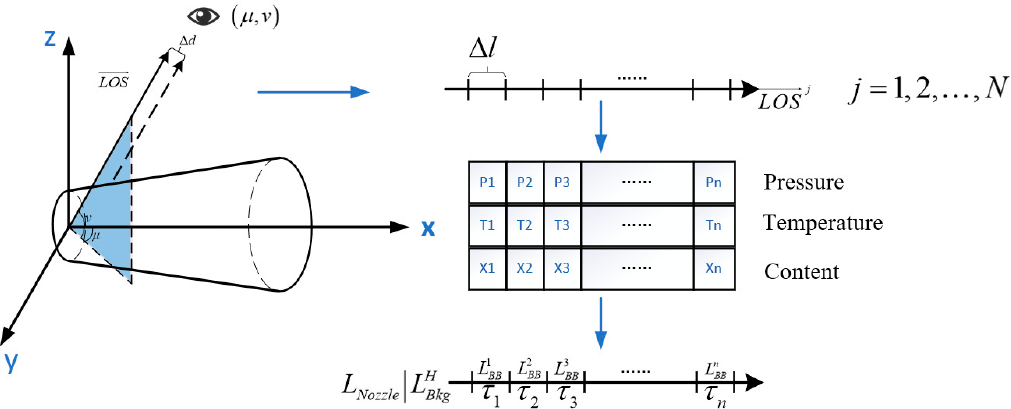
Figure 3. Observation line of sight uniform division schematic. ∆ l is the length of a slab; N is the total number of sight lines intersecting with the plume; µ and ν are the elevation and azimuth angles relative to the aircraft; P, T and X represent the gas pressure, temperature and species content respectively; n represents the number of stratified layers; ∆ d is the spatial sampling interval of LOS; L n is the blackbody radiance of the n-th slab; τ n denotes the transmissivity of the n-th slab;